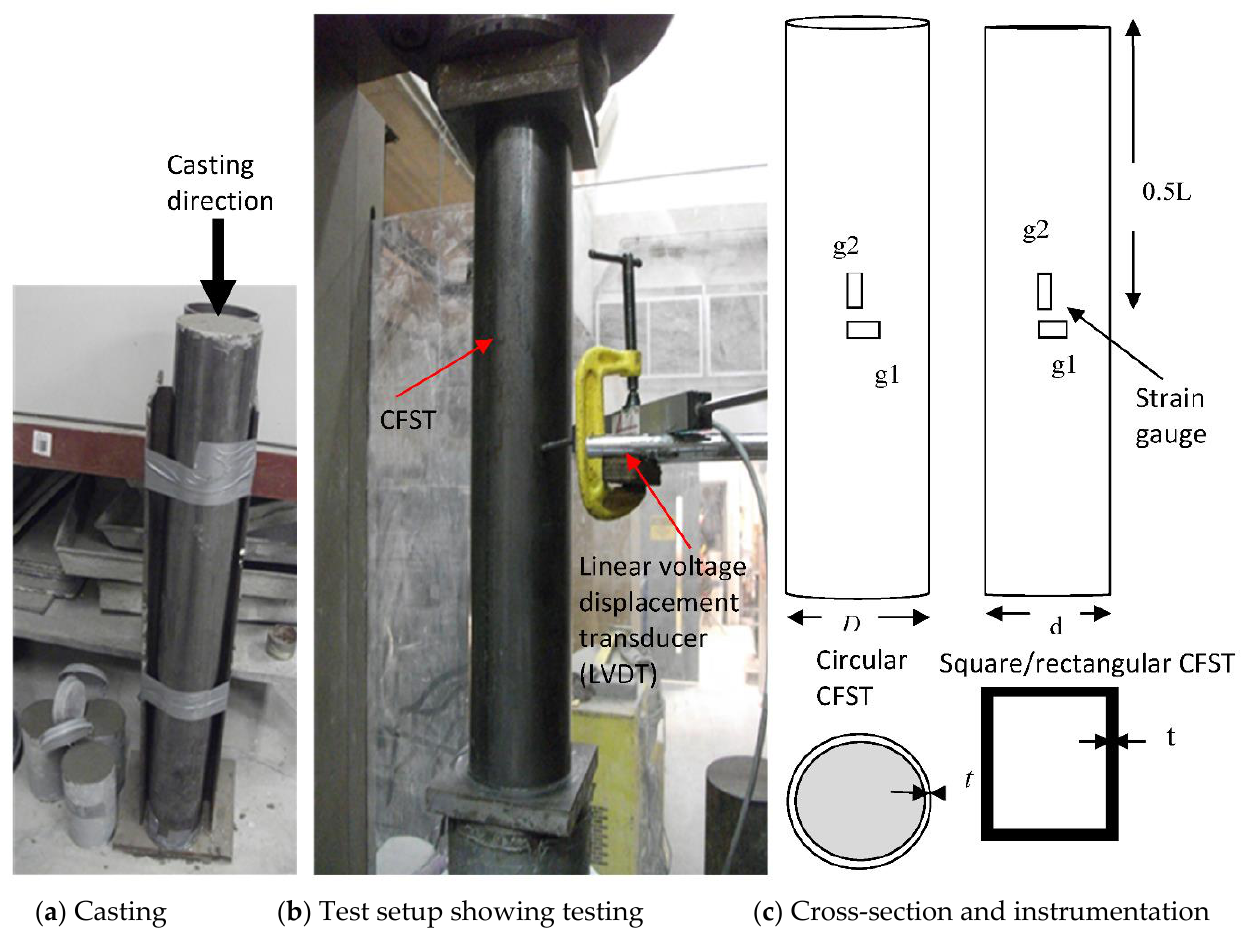
Figure 2. Experimental setup, casting, and instrumentation of CFST columns.